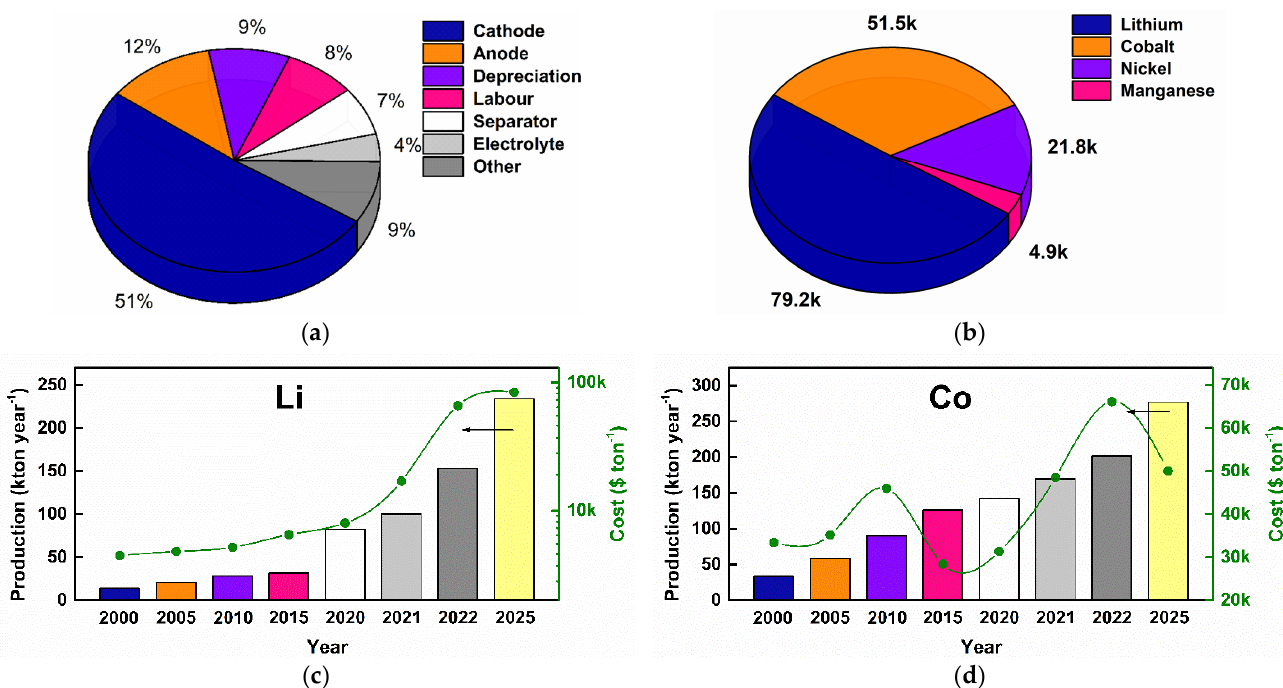
Figure 2. ( a ) Average cost specification for LIBs: components and service (data from [38,39]); ( b ) cost diagram of NMC cathode elements (in $ per ton): Li (>99.5% battery grade carbonate), Ni (>99.8%, ingots), Co (>99.8%, ingots), Mn (>99.7%, ingots) (data from [40–42]); ( c ) Li and ( d ) Co annual production (elemental, recalculated from ore mining) and cost in the 21st century: history and nearest forecast (data from [42–45]).